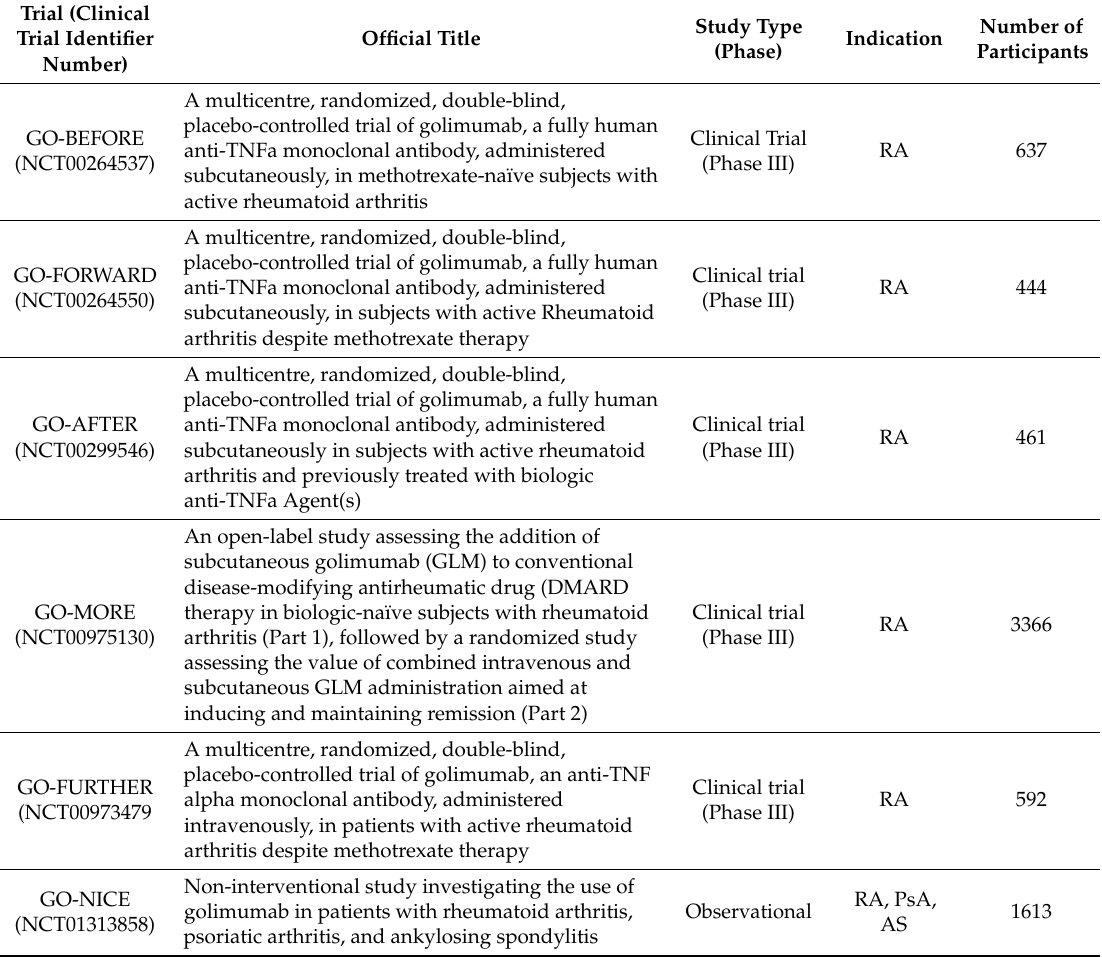
Table 1. Summary of GLM